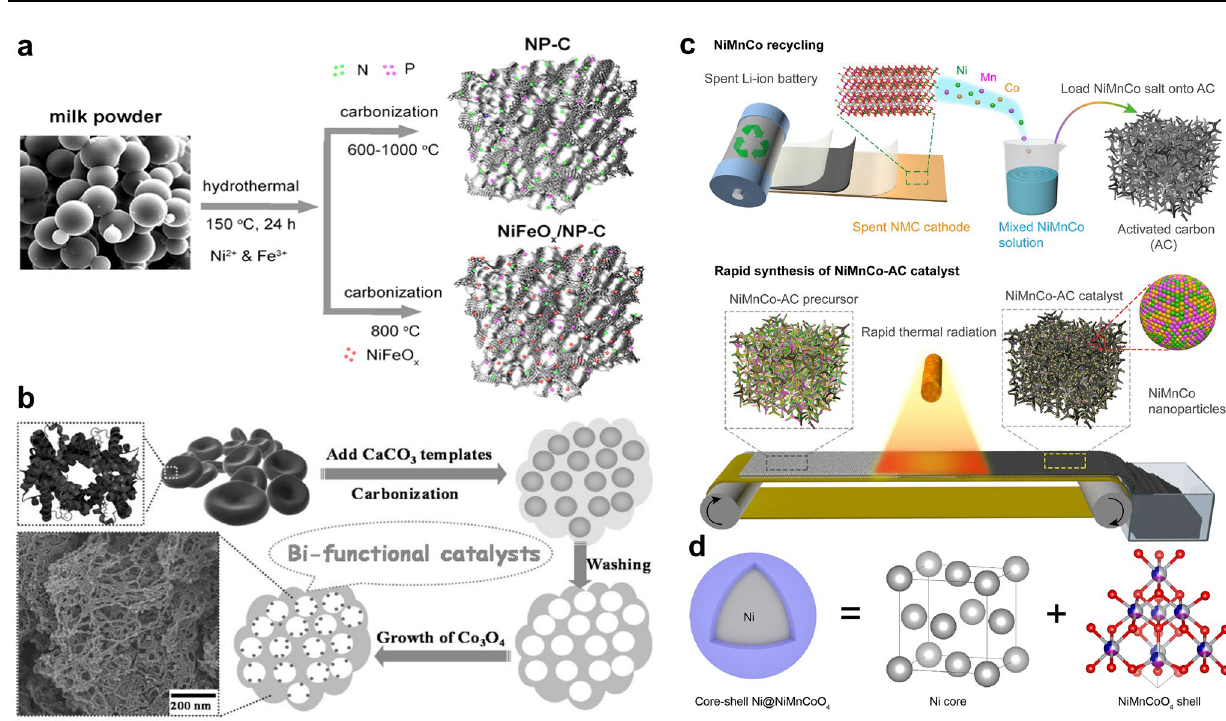
Fig. 10 a Scheme of the preparation of milk powder‑derived NP‑C and NiFeO x /NP‑C catalysts [163]. Copyright 2018, Elsevier. b Illustration of the synthesis of